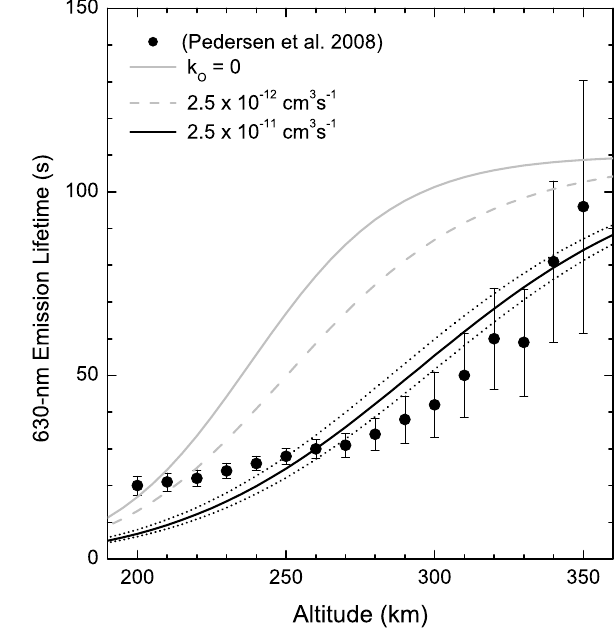
Fig. 2a. Observed O( 1 D) lifetime values as a function of altitude for representative IM experiments.